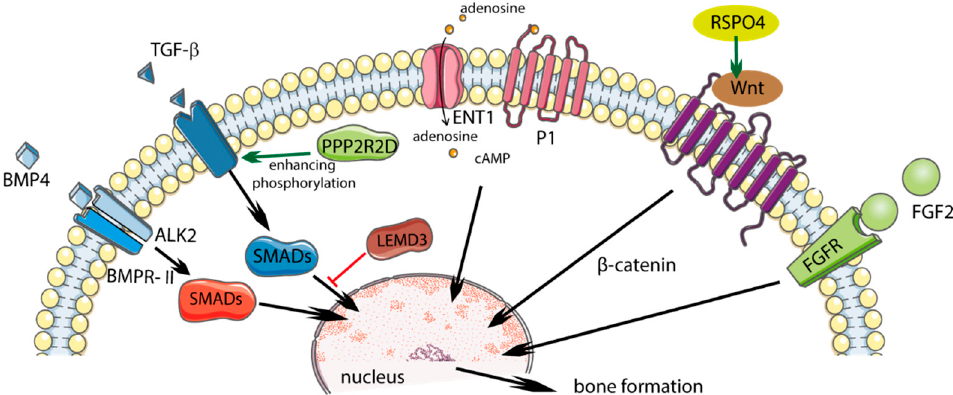
Figure 1. Potential role of polymorphism in diffuse idiopathic skeletal hyperostosis (DISH) and influence on regulatory pathways. Solid green arrows indicate activation; solid red bars indicate inhibition. Figure created using Servier Medical Art: https://smart.servier.com (accessed on 4 February 2021). [17].